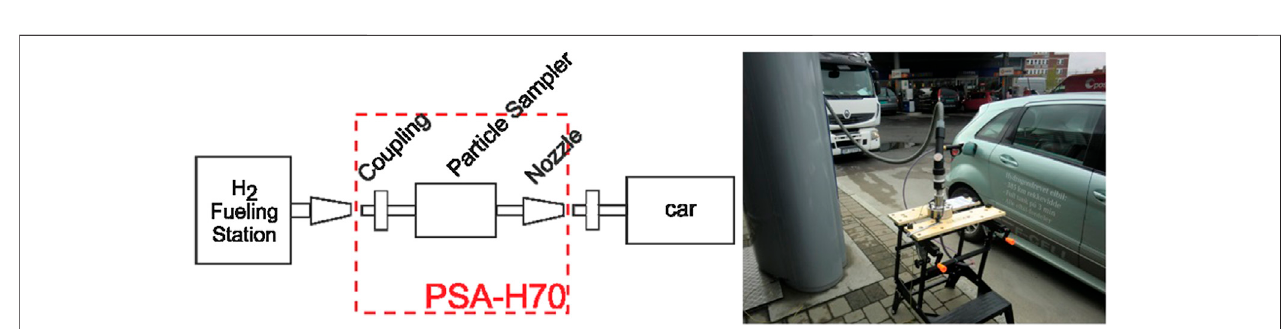
FIGURE 2 | Schematic of particulate sampling adapter (left) and use during refueling of FCEV (right) .